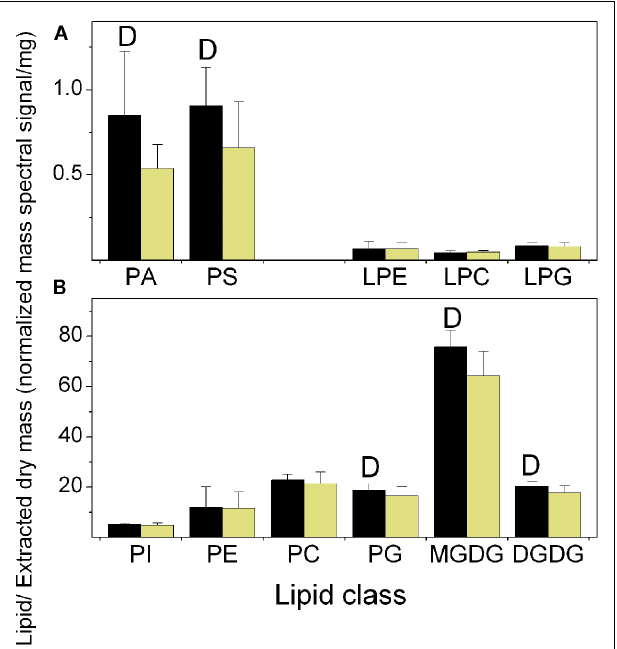
FIGURE 2 |Total lipid in each class at the end of the dark and light periods. The data are from Experiment 1. (A) Minor diacyl polar lipids and lysophospholipids, (B) Major diacyl polar lipids.The black bars represent the levels at the end of the dark period and the light yellow bars represent the levels at the end of the light period.The “D” symbol indicates that the amount of normalized mass spectral signal per extracted dry mass was significantly higher ( p < 0.05) at the end of the dark period than at the end of the light period in this experiment. n = 20 for dark; n = 19 for light.